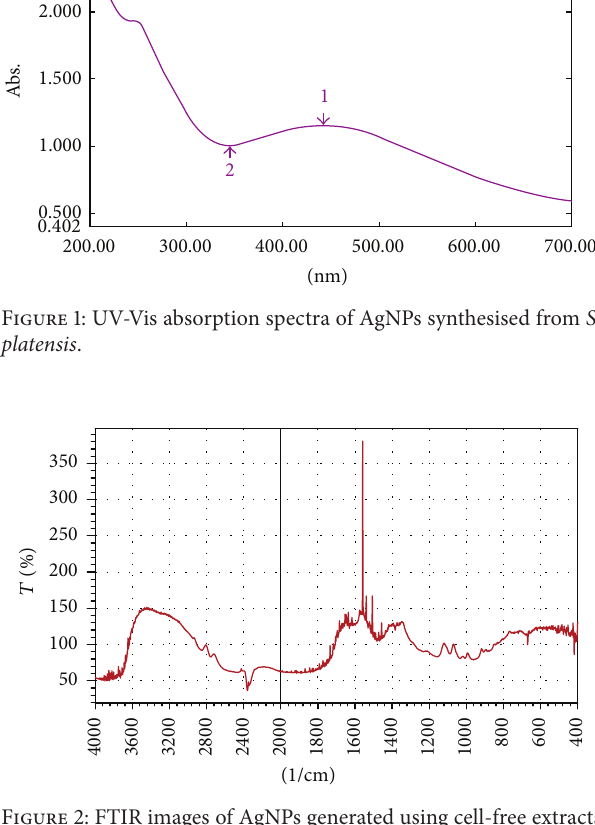
Figure 2: FTIR images of AgNPs generated using cell-free extracts of S. platensis